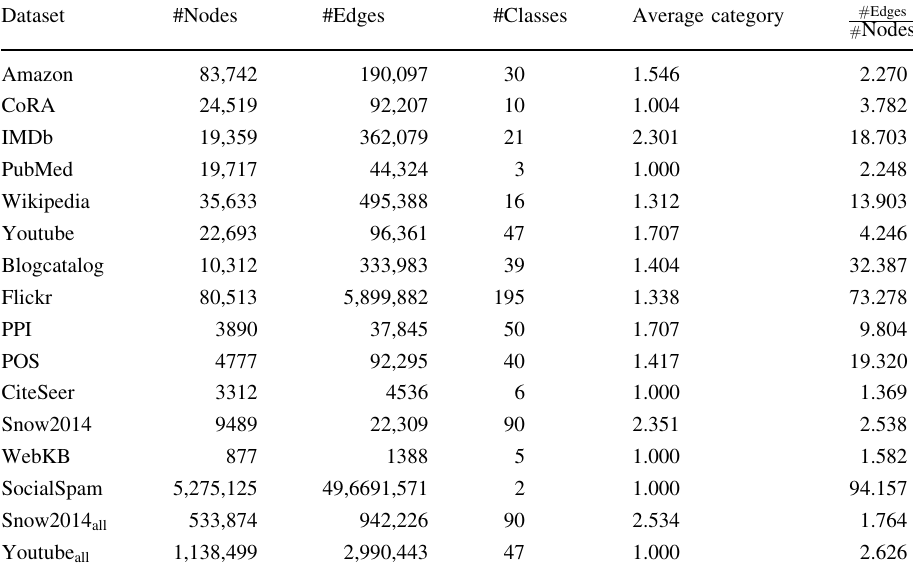
Table 2 Summary of undirected networks used for multi-label